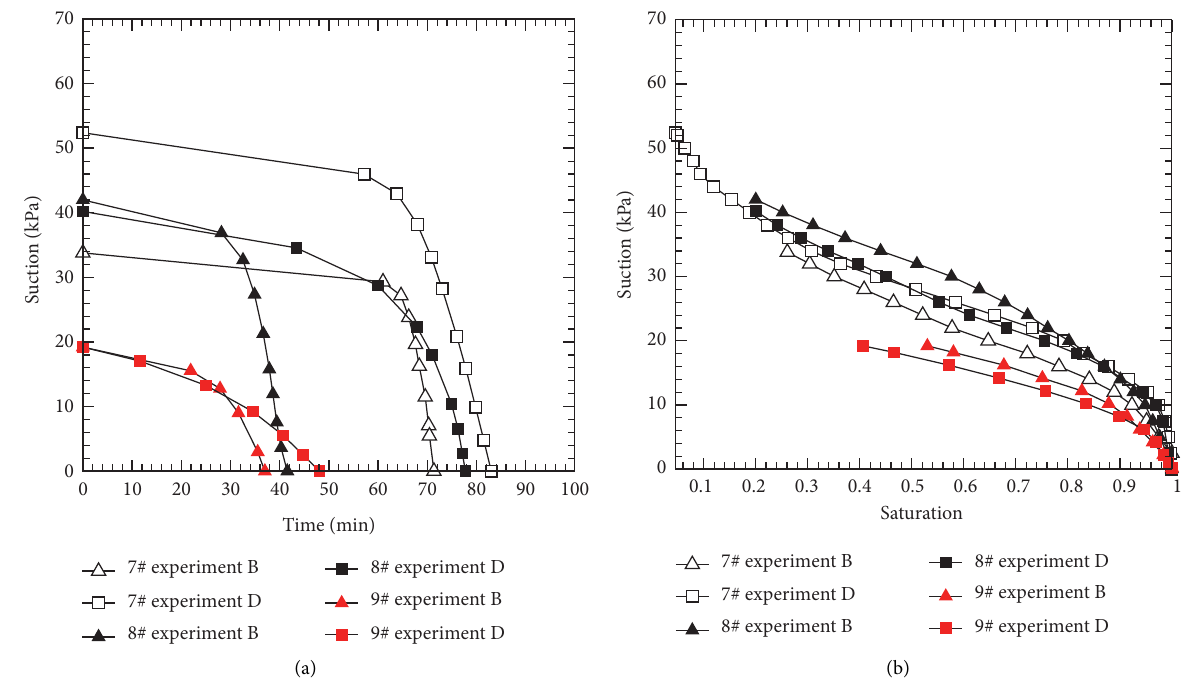
Figure 6: Plot of the experimental results for tensiometers in the fracture: (a) suction versus time; (b) suction versus